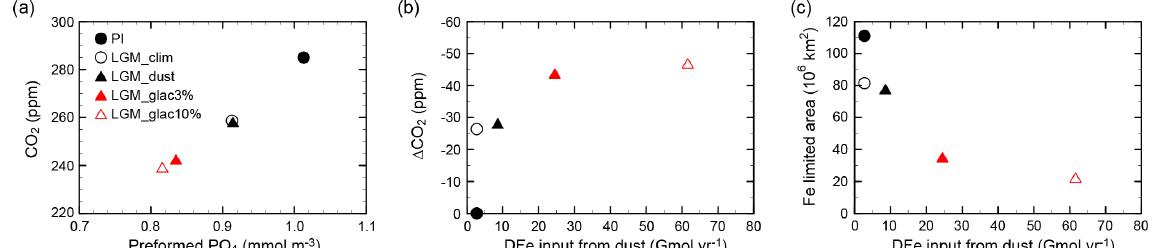
Figure 5. CO 2 change and its relationship to efficiency of the biological pump and iron cycle. (a) Atmospheric CO 2 as a function of globally averaged preformed PO 4 . (b) Changes in CO 2 from the PI as a function of DFe input from dust. (c) Fe-limited area as a function of DFe input from dust. Shown are the PI (black filled circle), LGM_clim (black open circle), LGM_dust (black filled triangle), LGM_glac3% (red filled triangle), and LGM_glac10% (red open triangle).